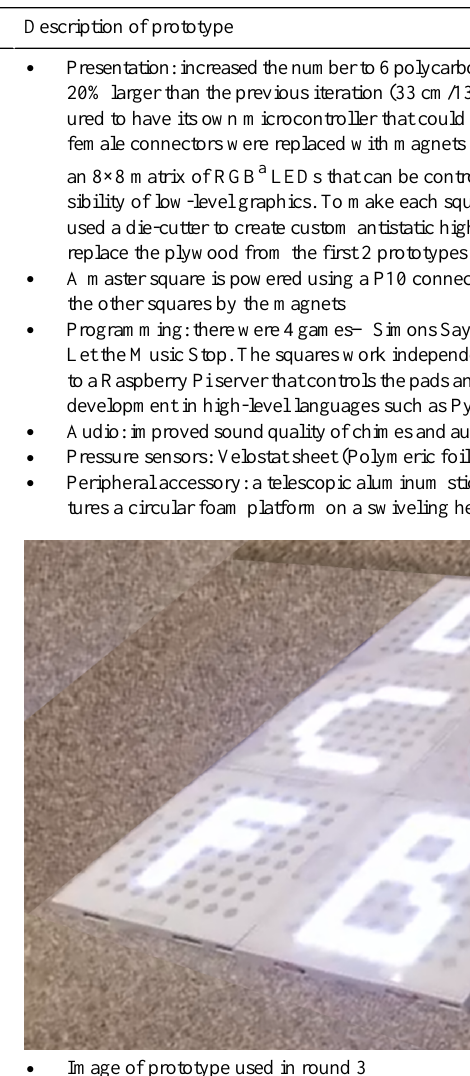
Table 3. Summary of iterative development process presented in rounds 3 and 4.